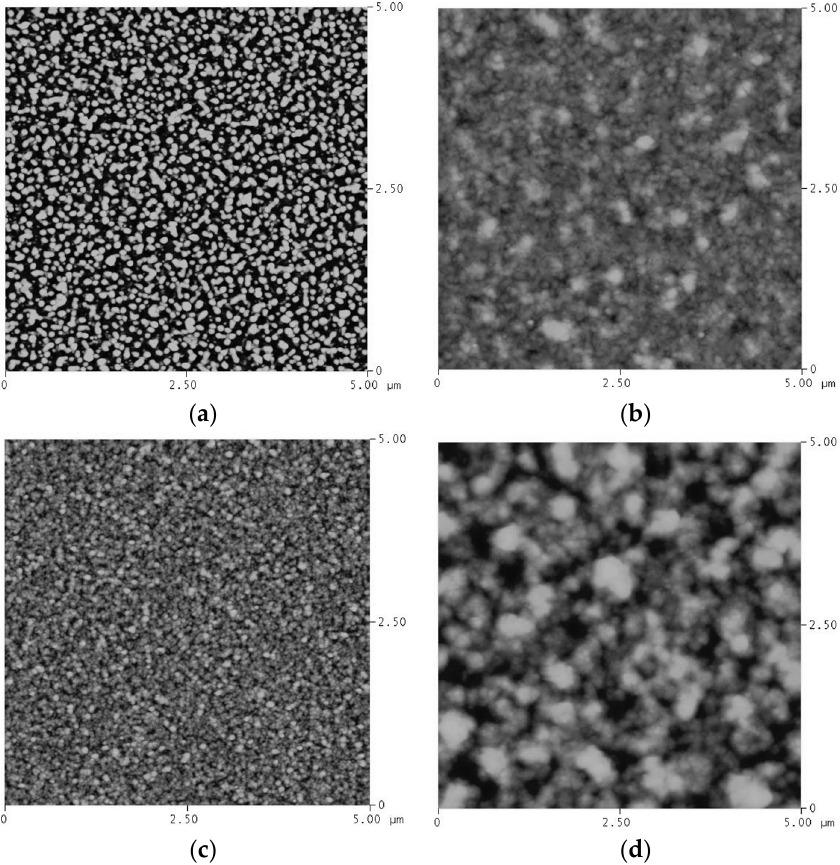
Figure 5. Atomic force microscopy (AFM) surface morphologies of Cu 40 Ag 60 and Cu 90 Ag 10 films, before and after annealing: ( a ) as-deposited Cu 40 Ag 60 ; ( b ) Cu 40 Ag 60 after annealing; ( c ) as-deposited Cu 90 Ag 10 ; ( d ) Cu 90 Ag 10 after annealing. Table 1. Surface roughness of Cu–Ag alloy films before and after annealing.